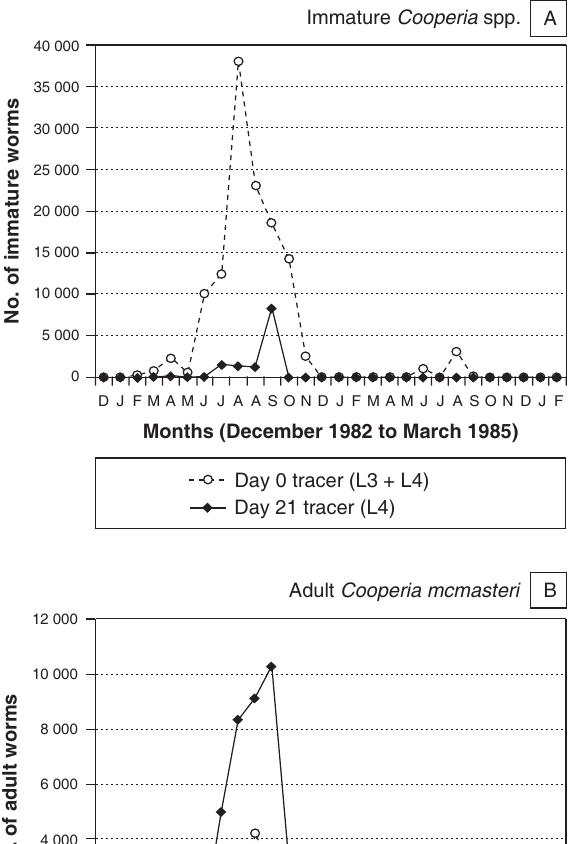
Parasites of domestic and wild animals in South Africa. XLV FIG. 4 Seasonality of A) Cooperia spp. larvae, B) adult Cooperia mcmasteri , and C) adult Cooperia oncopho- ra in tracer calves on the farm "Glen Dye", Eastern Cape Province. Two sets of calves were examined during August